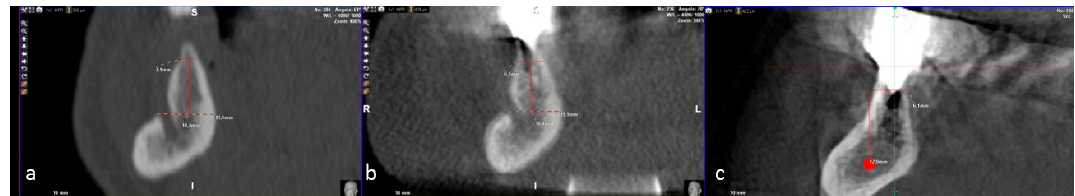
Figure 13. CT scans (element 45) performed before ( a ), 2 years after ( b ), and 6.5 years after implant rehabilitation. Before guided bone regeneration ( a ), the crestal bone thickness was only 3.1 mm. After the rehabilitation, during the follow-up period, the crestal bone thickness was maintained: it only decreased from 6.4 mm ( b ) to 6.1 mm ( c ).